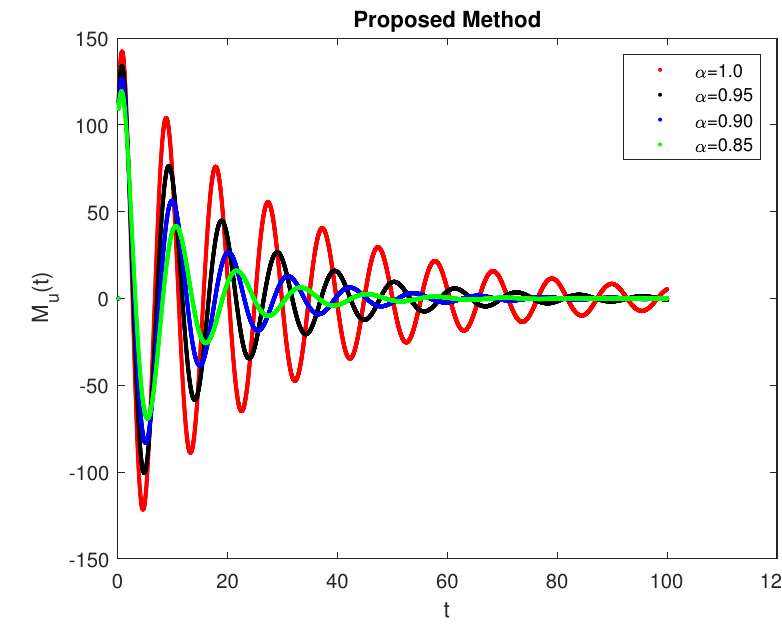
Figure 25: Numerical simulations for τ = 0.98 for Caputo-Fabrizio derivative.